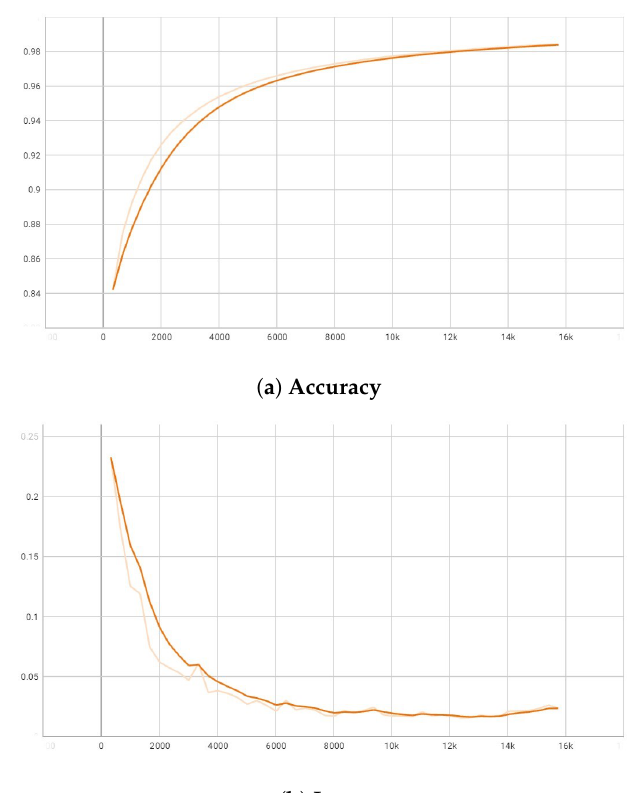
Figure 8. VulEye valid performance.